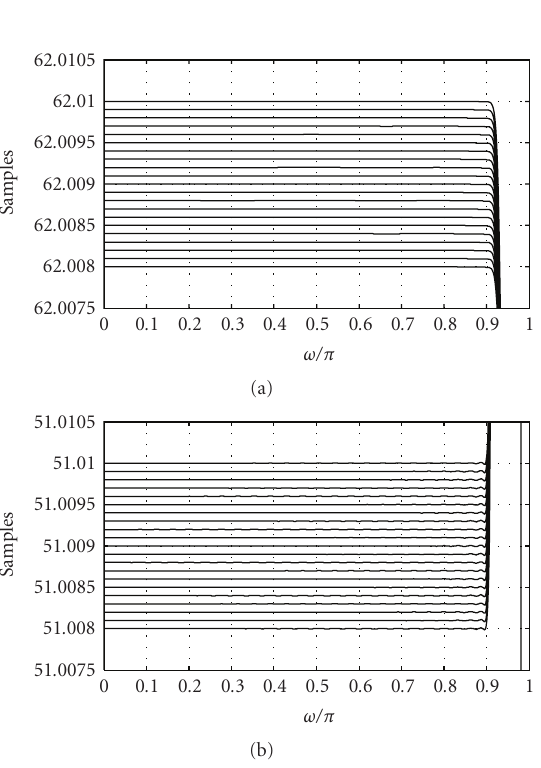
Figure 8: All band fractional delay responses for (a) proposed method and (b) direct all band